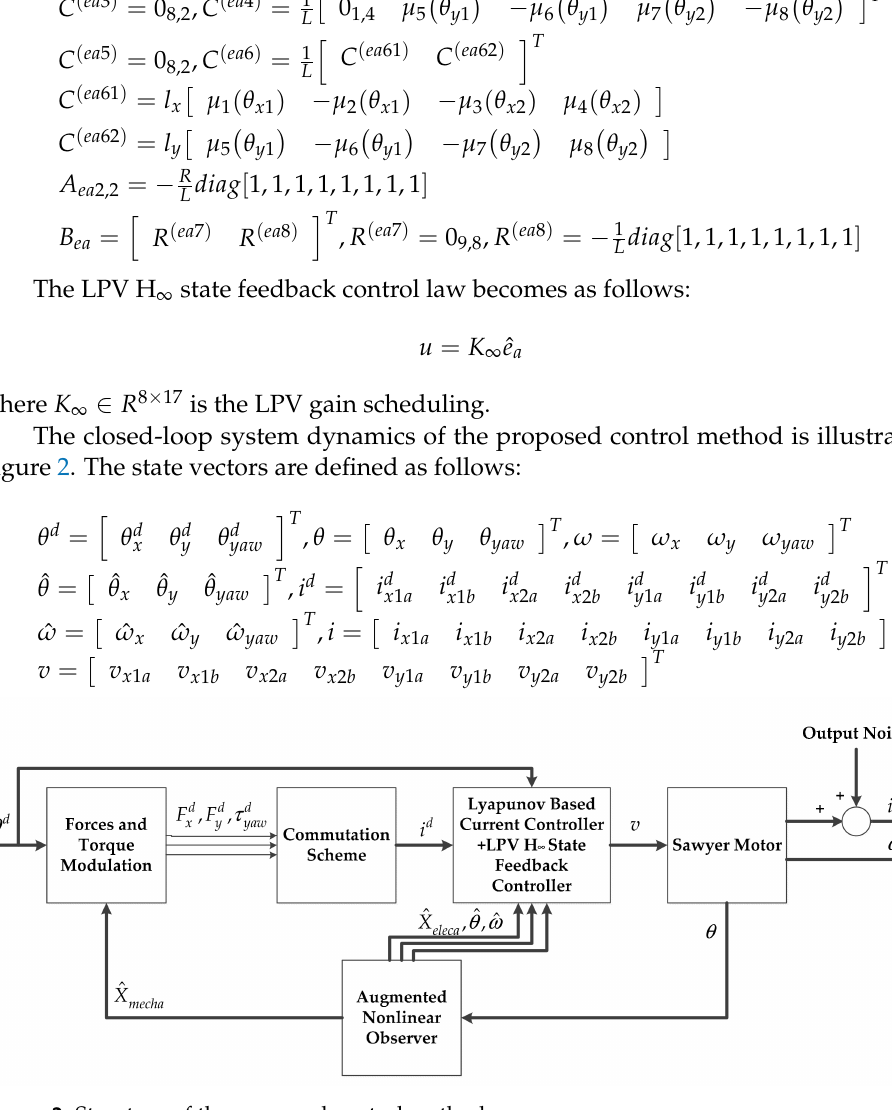
Figure 2. Structure of the proposed control